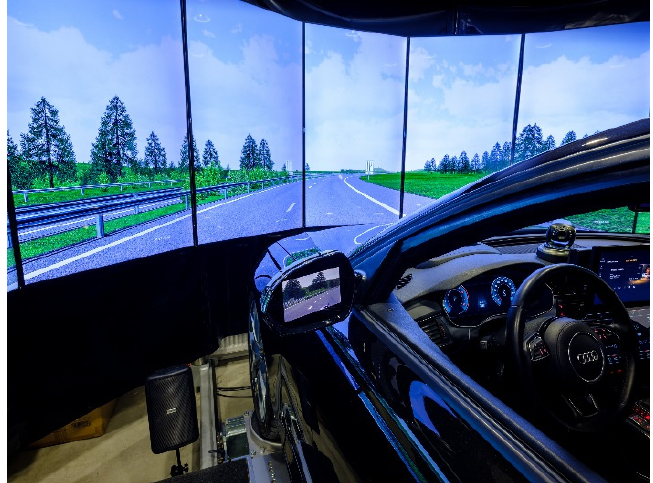
Figure 4. Static driving simulator used for this study.